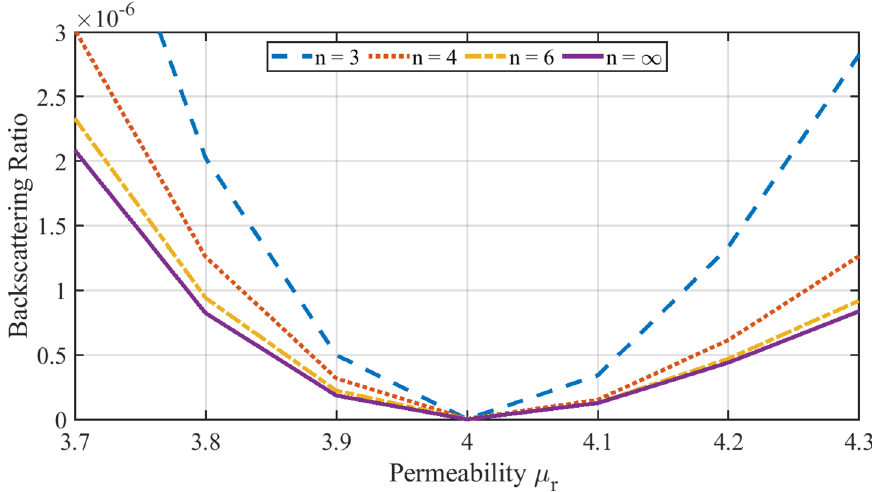
4 as a function of =